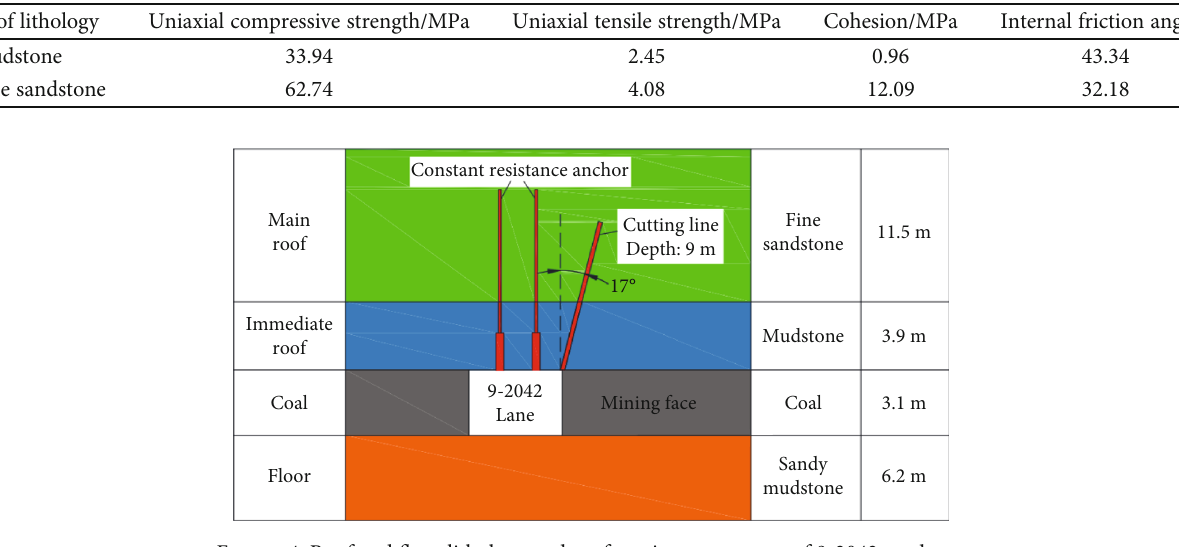
Figure 4: Roof and fl oor lithology and roof-cutting parameters of 9-2042 roadway.